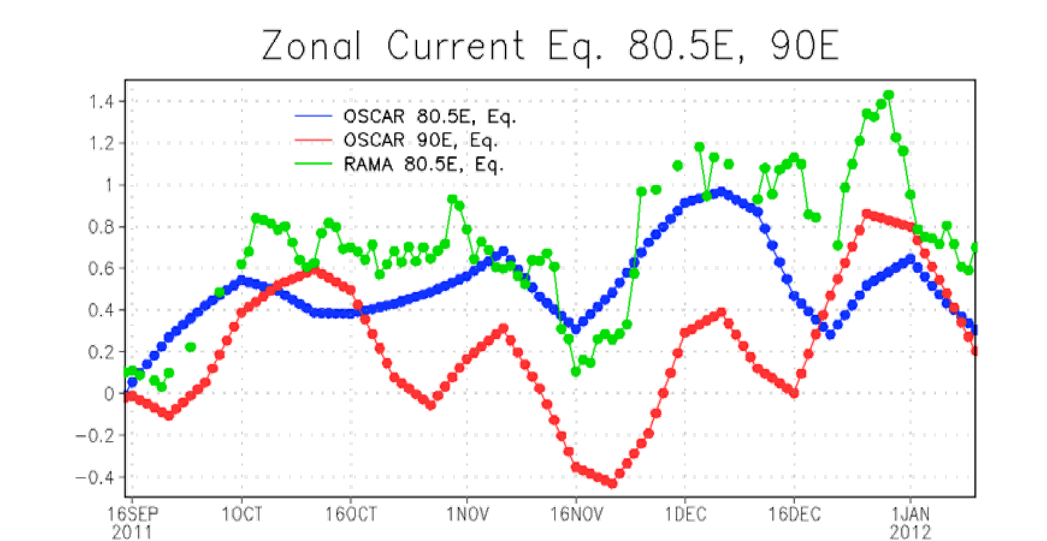
Figure 4. Zonal current (m/s) at 10 m at 80.5°E, equator (blue line) and 90°E, equator (red line) from OSCAR, and at 80.5°E, equator from the RAMA buoy (green